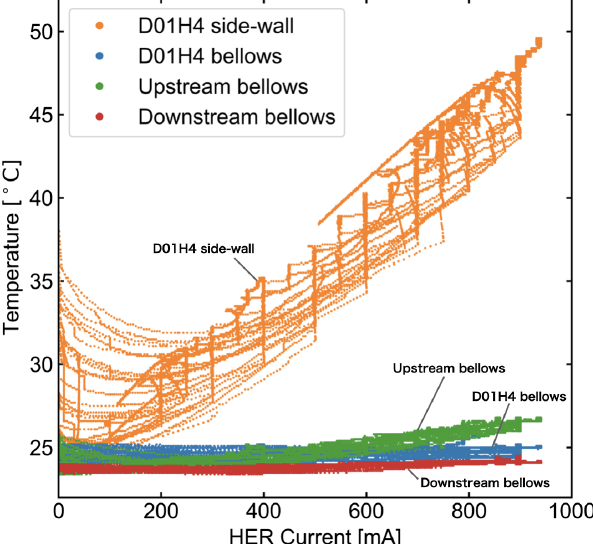
FIG. 15. Temperature on the D01H4 collimator and bellows chambers beside it, measured with RTDs, as a function of beam current in the HER. The flow rate of the cooling water was approximately 4 L min − 1